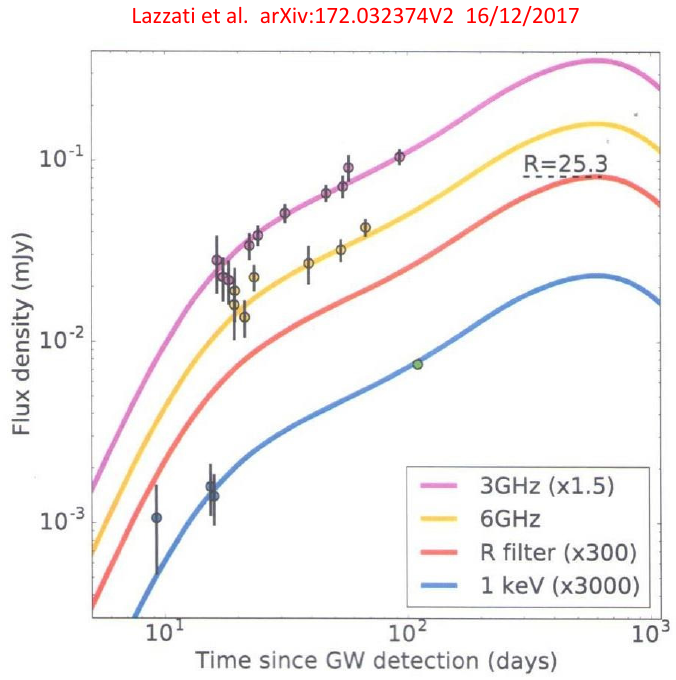
Figure 36. Best fit light curves of an off-axis structured jet model [192] to the ROX AGs of SHB170817A measured before December 2017 (Figure from the first version of [192] posted in the arXiv on 8 December